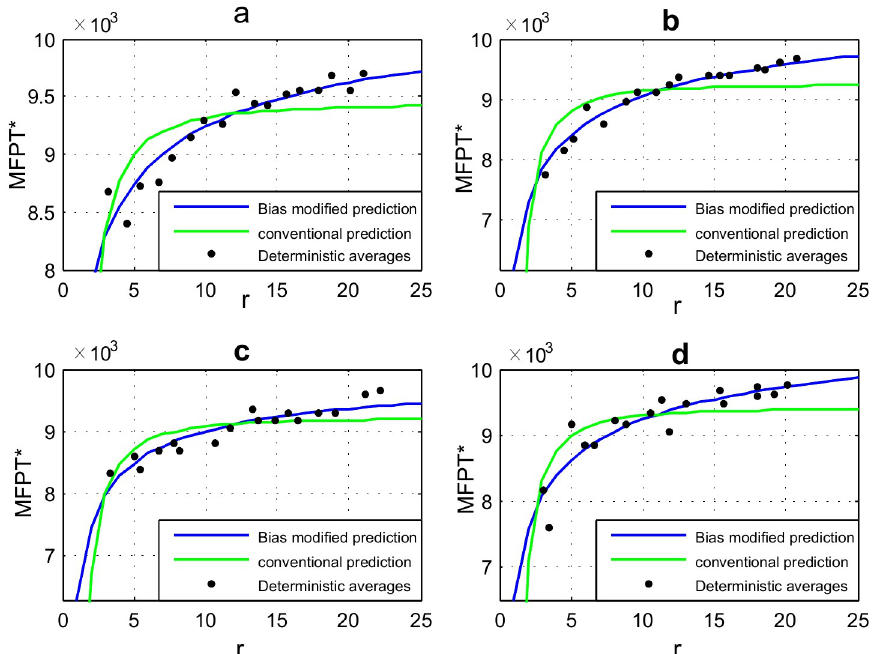
Fig 6. Numerically averaged MFPT � s using Monte-Carlo simulations (bold dots) compared to theoretical curve fits using bias-modified and conventional transport variables for networks with (a) ( U = 1.2, σ = 0) (b) ( U = 0.8, σ = 0.3), (c) ( U = 1, σ = 0.5), (d) ( U = 1.2, σ = 0.7). The r-squared value sets obtained for curve fitting using conventional and bias-modified variables for the four cases were [0.60713, 0.88098], [0.64693, 0.95868], [0.61473, 0.86012] and [0.65008, 0.82429]